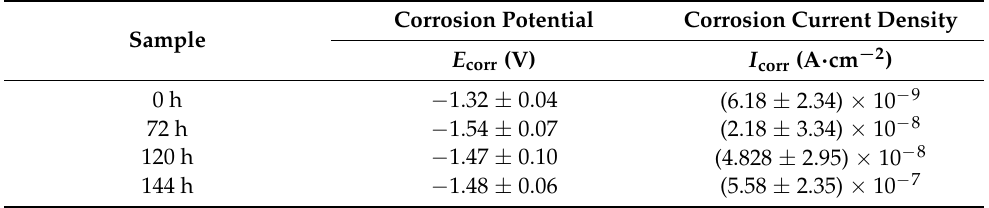
Figure 14. Potentiodynamic polarization curves of the superhydrophobic coatings before and after salt spray experiment ( a : 0 h, b : 72 h, c : 120 h, d : 168 h). Table 1. Corrosion parameters of the samples.